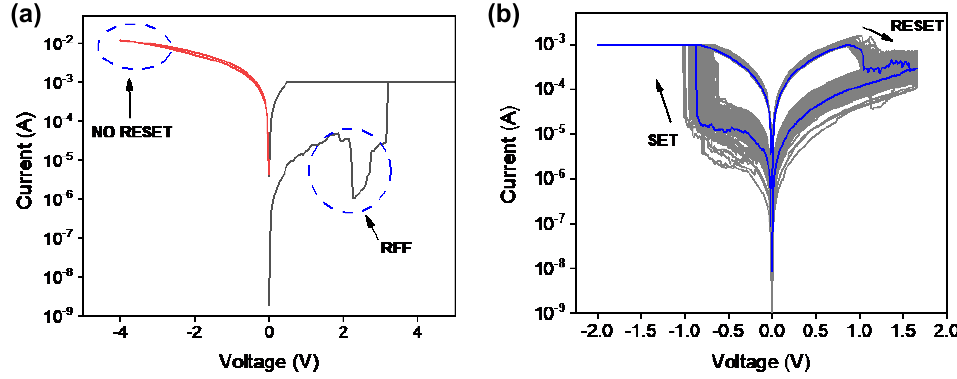
Figure 3. The I-V characteristics of the Pt/SiO X /TaN RRAM device under ( a ) positive set and negative reset operation, and ( b ) negative set and positive reset operation.